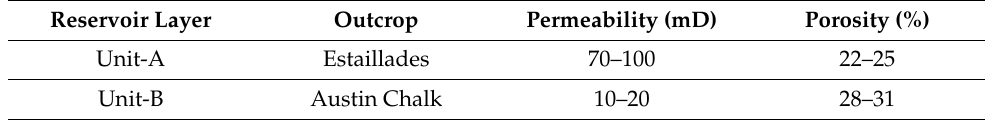
Table 2. Properties of Unit-A and Unit-B representative outcrop rocks.